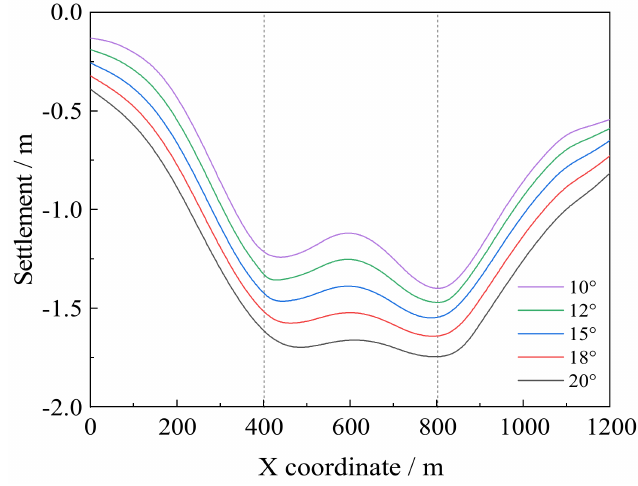
Figure 15. Settlement curves corresponding to different slope